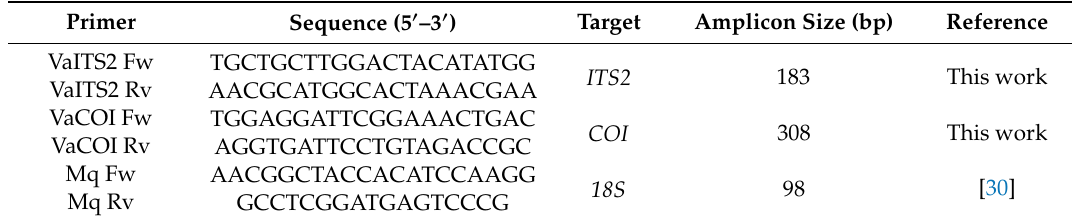
Table 2. Primers used in this